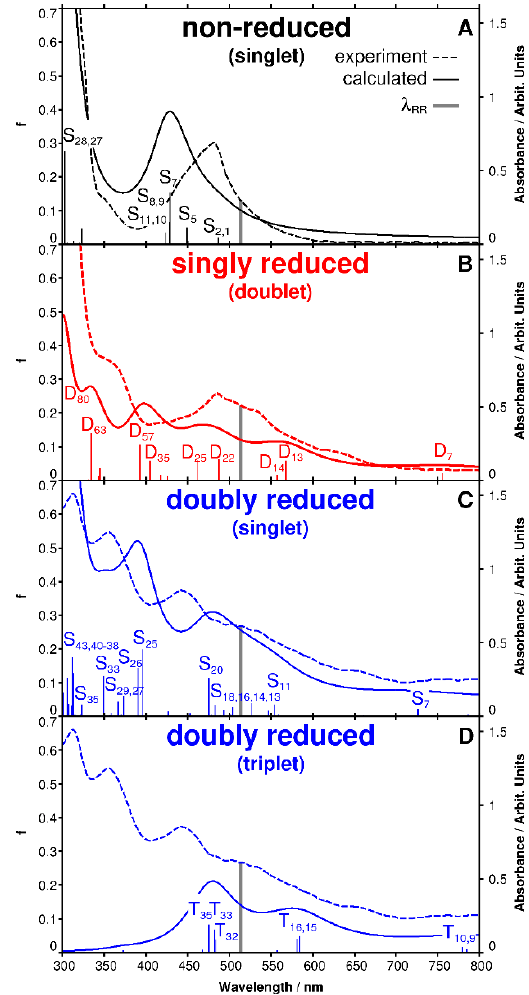
Figure 2. Experimental (dashed line) and theoretical absorption spectra of [Ru(tbtpy) 2 ](PF 6 ) 2 (solid line and bars), obtained at the time-depended density functional (TDDFT) level of theory with the B3LYP functional and the 6-31G(d) basis set and applying a PCM model to consider effects of solvation (ACN) of the ( A ) non-reduced specie (E ocp ), ( B ) singly reduced specie, and ( C ) doubly reduced species of singlet and ( D ) triplet multiplicity, respectively. The vertical gray line indicates the excitation wavelength for the resonance Raman spectro-electrochemistry (RR-SEC) measurements. The experimental spectra for the singly and doubly reduced [Ru(tbtpy) 2 ](PF 6 ) 2 (0.55 M in ACN containing 0.1 M TBABF 4 ) are collected after polarizing the electrode for 300 s at − 1.45 and − 1.70 V, respectively.